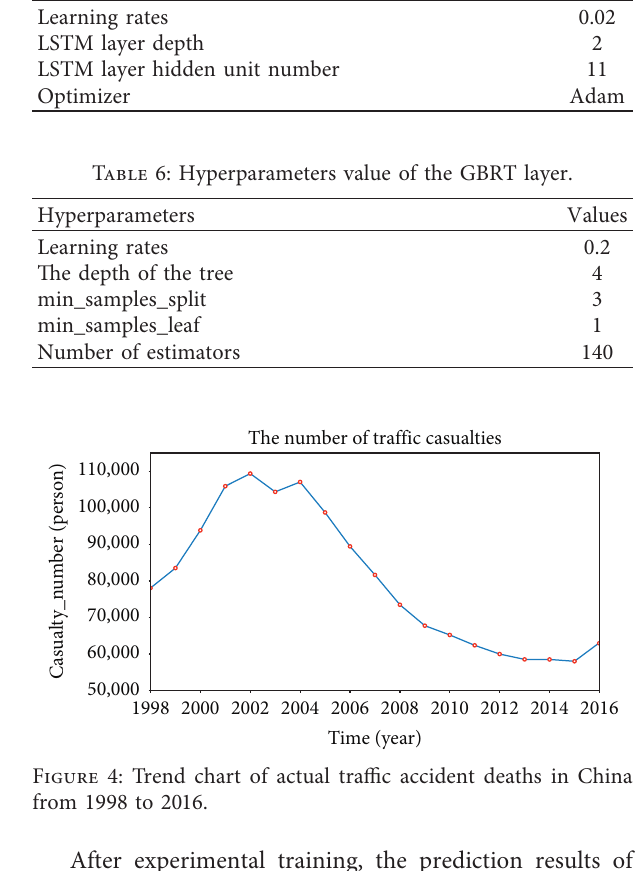
Table 3: Death prediction for different hidden nodes. Hide_size E (2013) E (2014) E (2015) E (2015)